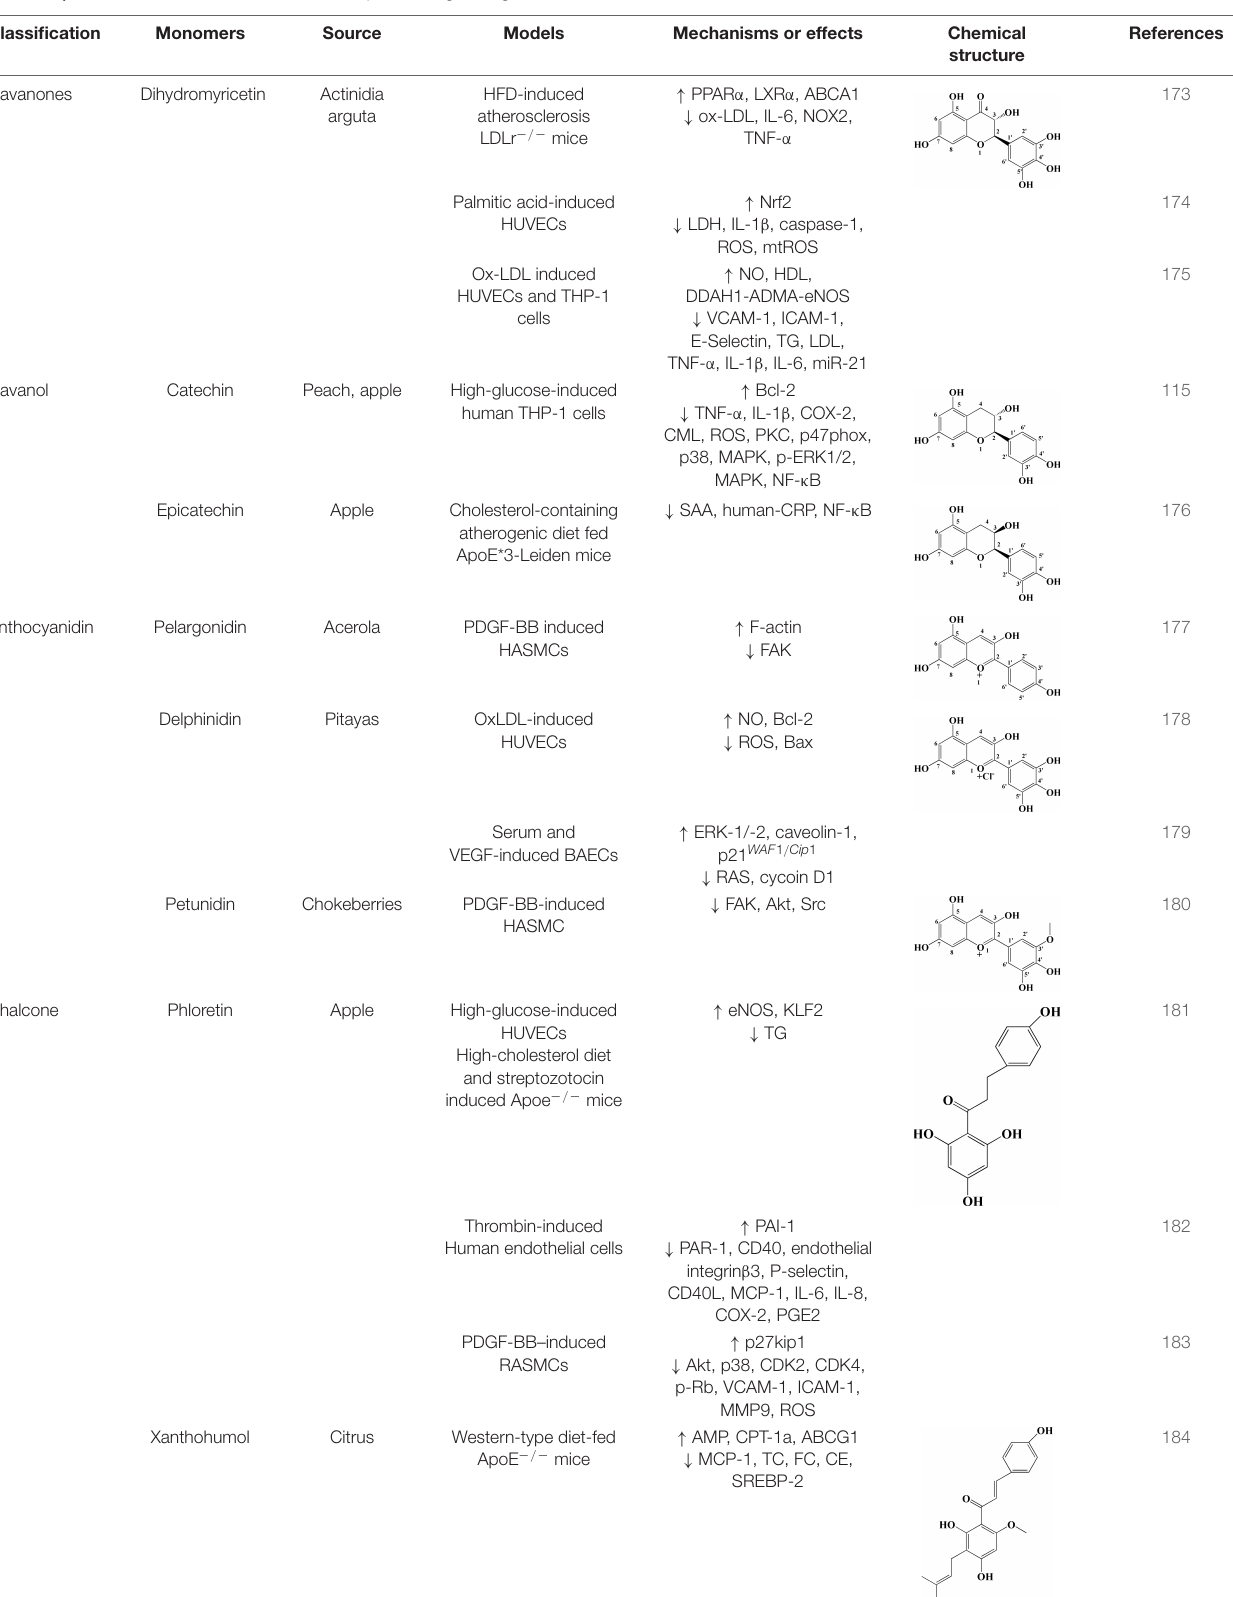
TABLE 2 | Other flavonoids derived from fruits are potential agents against Atherosclerosis.